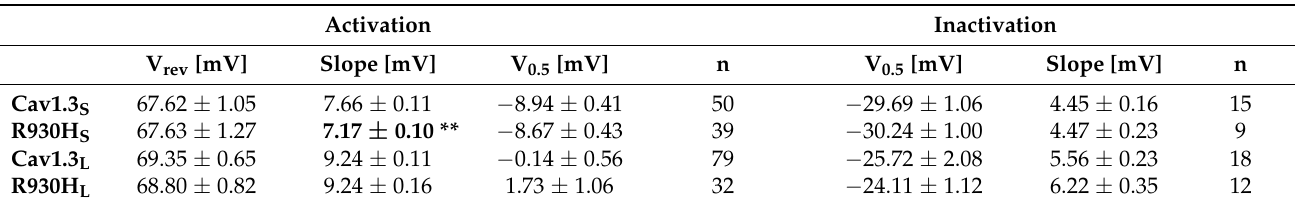
Table 2. Comparison of activation and inactivation parameters of wild-type (native) Cav1.3 and the Cav1.3 R930H channels. Figure 3. The R930H variant induces transcript variant dependent gating changes of Cav1.3